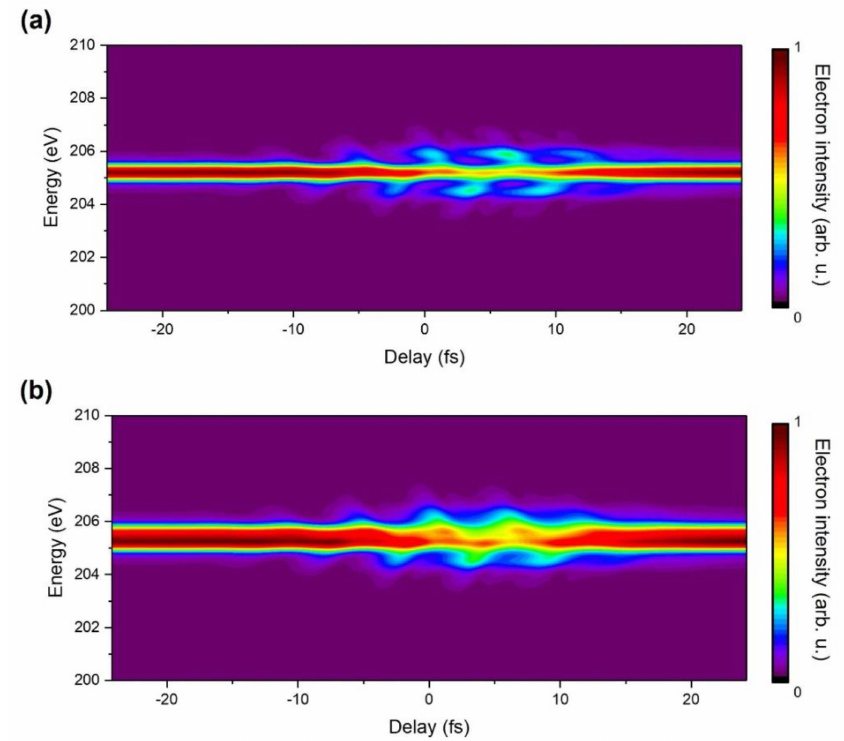
Figure 3. ( a ) Calculated spectrogram of the argon Auger emission of 205.21 eV with the convolution effect which is related to the spectral resolution of the experimental setup. ( b ) The calculated spectrogram of two close argon Auger emissions of 205.21 eV and 205.62